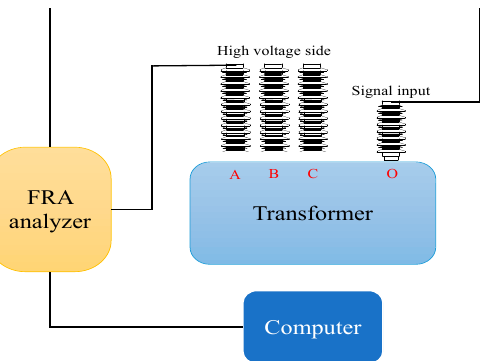
Figure 1. FRA (frequency response analysis) measurement for star-connected winding.